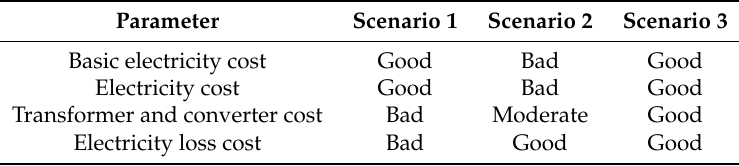
Table 7. Advantages and disadvantages of three BESS configuration